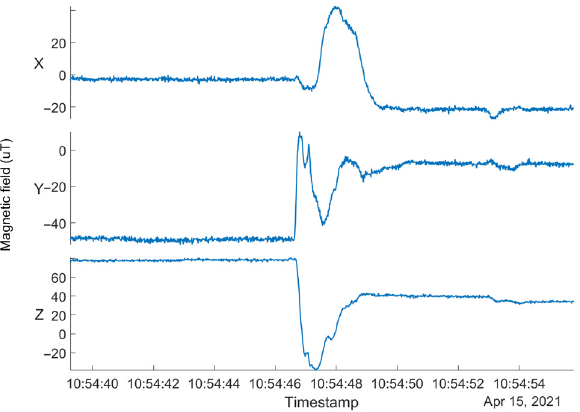
Figure 5. Triaxial magnetometer data before and after switching on the electric motor of the rotating platform. The initial disturbance in the magnetic field is caused by switching on the electric motor. With the platform in operation, the magnetometer data exhibit a permanent shift in all three axes.